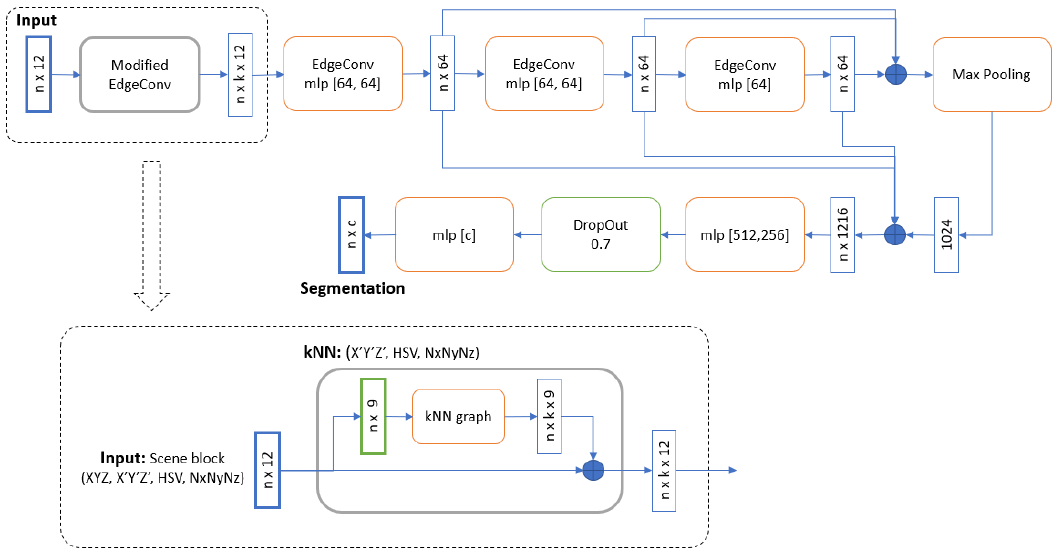
Figure 3. Illustration of our modified DGCNN